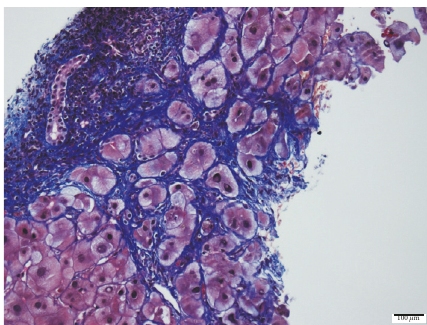
Figure 3: Liver biopsy showing nodules and fibrous septa associated with effacement of lobular architecture in Masson’s trichrome stain.